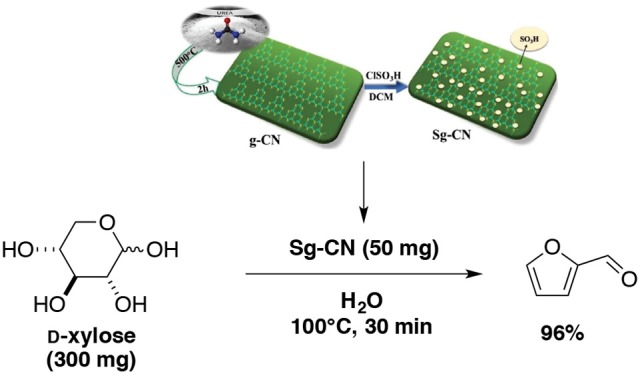
Production of furfural from D-xylose in the presence of sulfonated graphitic carbon nitride in water (Verma et al., 2017).